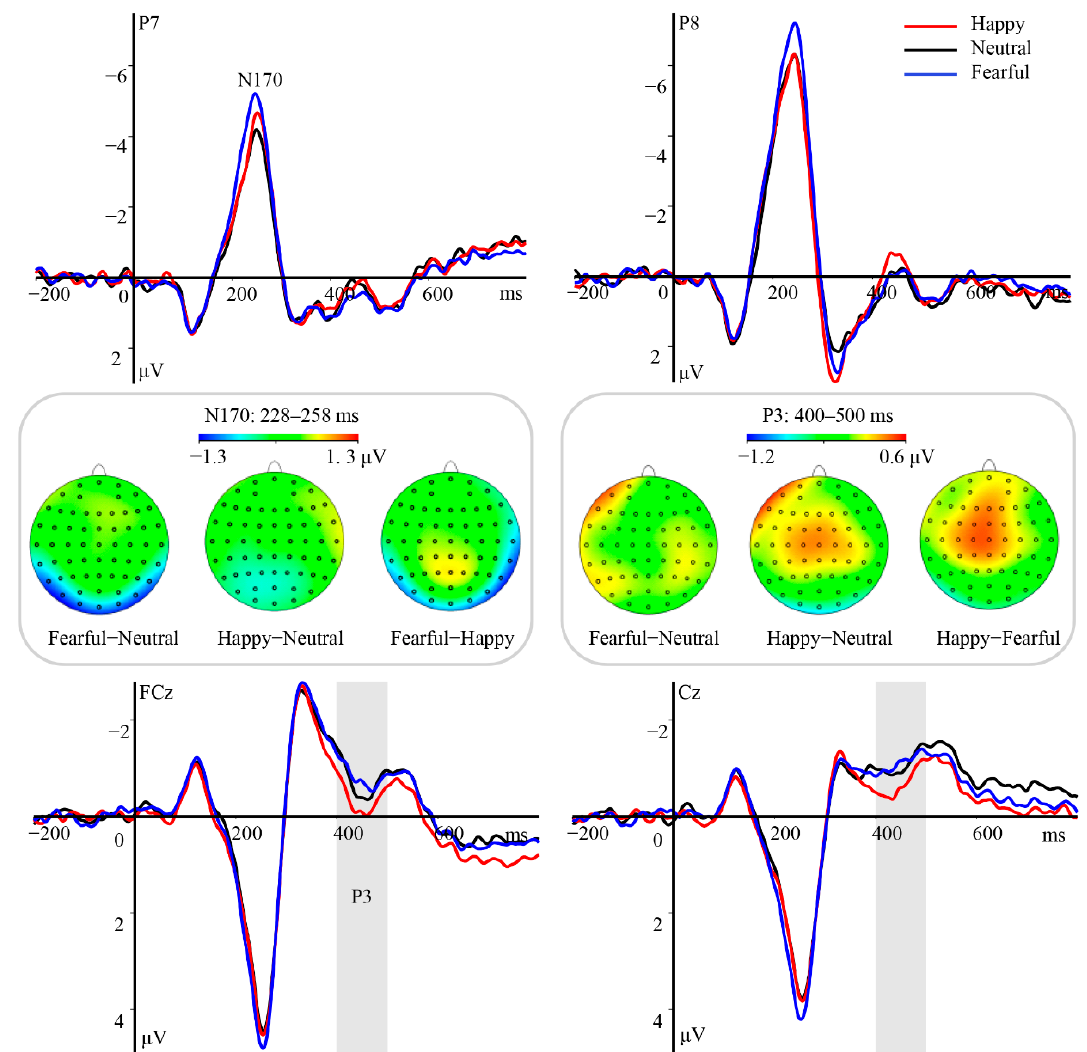
Figure 4. Main effects of emotional valence of eye regions on N170 and P3 amplitudes in Experiment 2. Top and bottom panels: Grand average ERP waveforms of N170 and P3 for happy (red line), neutral (black line), and fearful (blue line) eye regions at the indicated electrodes. Gray area indicates the time window for the P3 component (400–500 ms). Middle panel: Topographical difference maps depicting the effect of emotional valence in eye regions during the time windows for N170 and